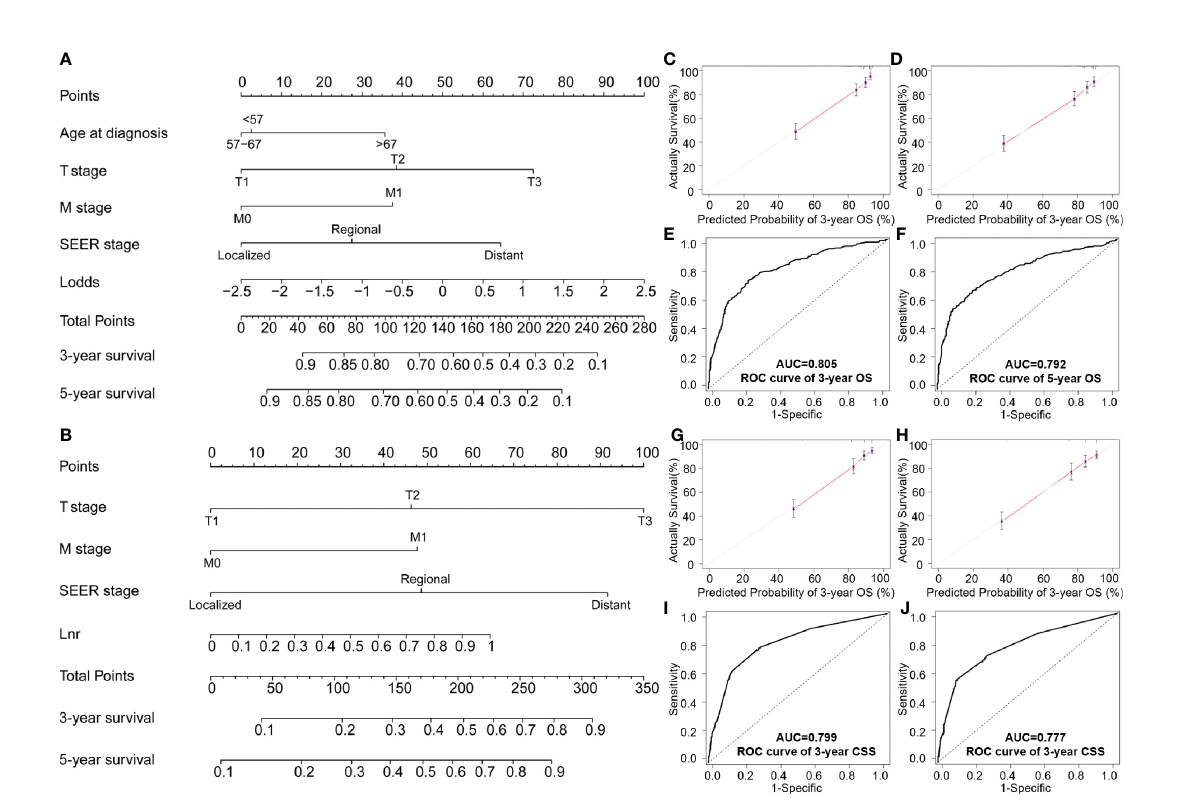
FIGURE 3 Nomogram testing of: (A) Overall survival; (B) CSS nomogram at predicting 3- and 5-year survival; (C, D) 3- and 5-year survival curves for OS; (E, F) ROC analysis of age, T stage, M stage, SEER stage and LODDS for OS; (G, H) 3- and 5-year calibration curves for predicting CSS; (I, J) ROC analysis of stage, M stage, SEER stage and LNR for